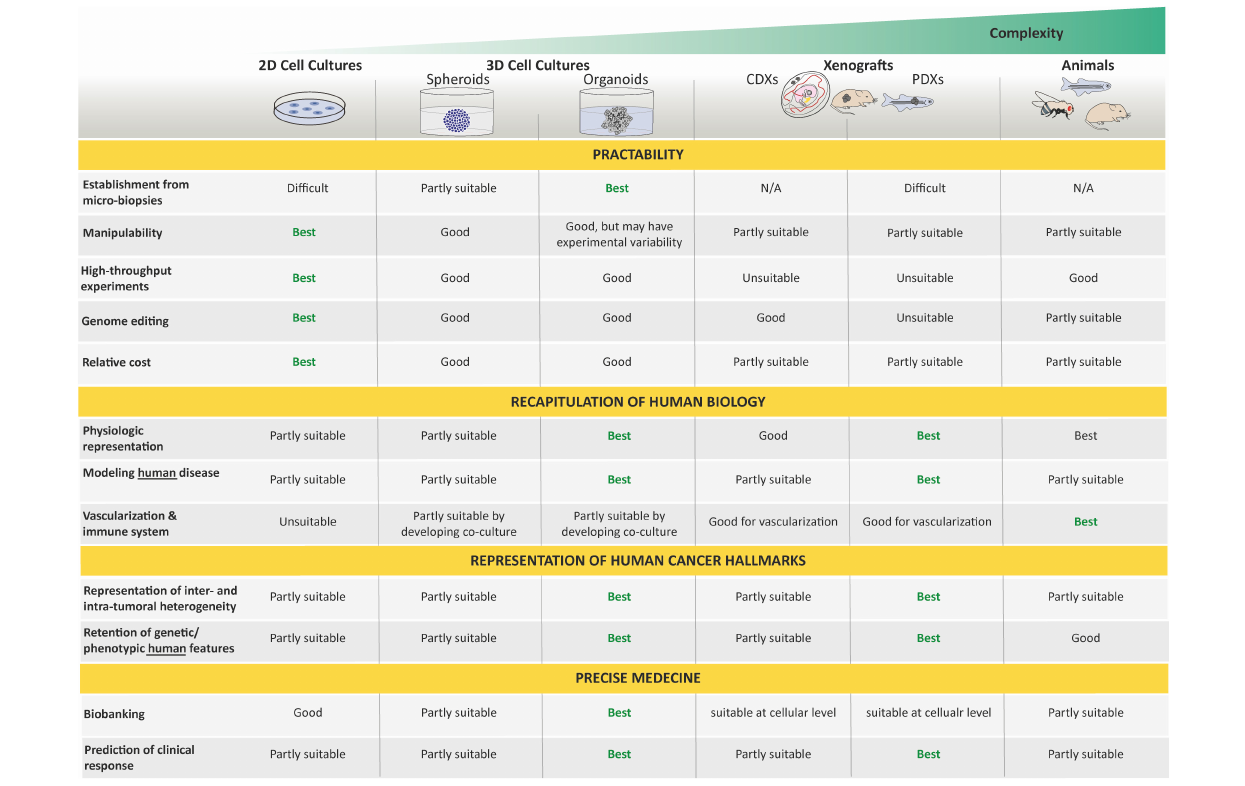
FIGURE 7 | Strengths and weaknesses of organoids in cancer modeling. Organoids are assessed here for their relative benefits and limitations for cancer research by comparison with other model systems. Respective features are rated as best, good, partly suitable, and unsuitable. By bridging the gap between conventional 2D culture and animal models, organoids provide a unique opportunity to deal with a moderate system complexity meanwhile capturing the complexity of tumors. N/A,